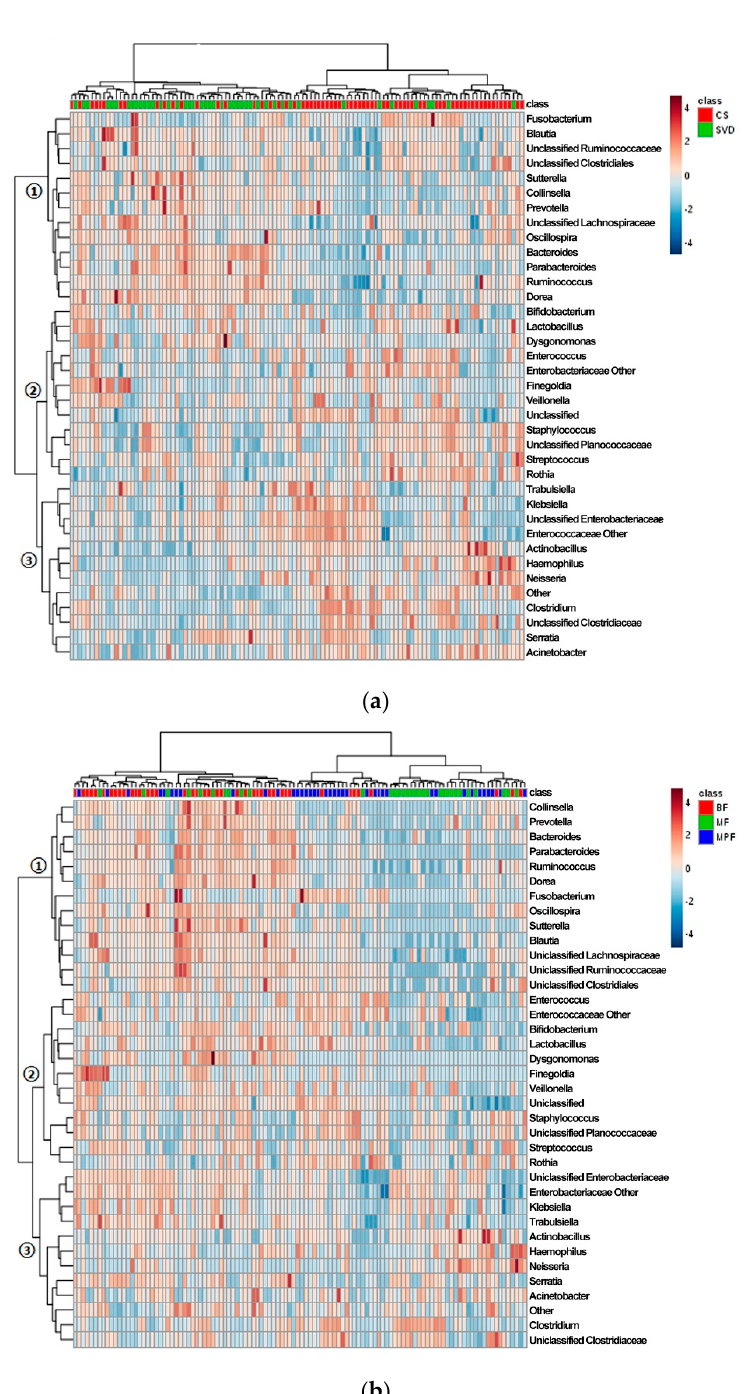
Figure 4. Cluster analysis of infant gut microbiota in different delivery modes and feeding methods. ( a ) Delivery modes; ( b ) Feeding methods. Only those genera (side) that were present in at least 1% 0f samples (top) were shown.